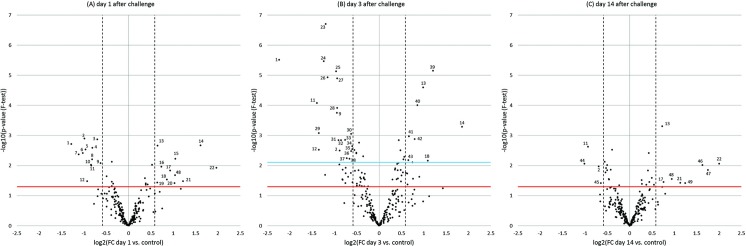
Volcano plots showing miRNA expression changes as obtained by RNAseq.A) day 1 after challenge, B) day 3 after challenge, C) day 14 after challenge. x-axes show the log2FC values of post-challenge time points vs. unchallenged controls. 50% up- or down-regulation is denoted by vertical dotted lines (log2FC > 0.585, log2FC < -0.585). y-axes show the -log10 transformed p-values obtained from F-tests. p = 0.05 is denoted by a horizontal red line. A horizontal blue line denotes the p-value limit for significant differential expression when controlling for FDR; as shown, only on day 3 after challenge are there any miRNAs that are significantly differentially expressed after this correction. miRNAs that pass the criteria for differential expression are marked with a number denoting their identity; miRNAs that appear in more than one volcano plot are marked with the same number in all plots. 1 ssc-miR-205; 2 ssc-miR-34c; 3 ssc-miR-671-5p; 4 ssc-miR-146a-5p; 5 ssc-miR-2366; 6 ssc-miR-365-5p; 7 ssc-miR-146b; 8 ssc-miR-708-5p; 9 ssc-miR-92b-5p; 10 ssc-miR-708-3p; 11 mmu-miR-34b-3p; 12 mmu-miR-34b-5p; 13 ssc-miR-339-3p; 14 ssc-miR-196b-5p; 15 ssc-miR-193a-3p; 16 ssc-miR-4334-3p; 17 ssc-miR-133b; 18 ssc-miR-217; 19 ssc-miR-331-3p; 20 ssc-miR-216; 21 ssc-miR-187; 22 ssc-miR-144; 23 ssc-miR-296-3p; 24 ssc-miR-92b-3p; 25 ssc-miR-1343; 26 hsa-miR-375; 27 ssc-miR-744; 28 ssc-miR-7134-5p; 29 ssc-miR-190b; 30 ssc-miR-2320-3p; 31 ssc-miR-671-3p; 32 ssc-miR-128; 33 ssc-miR-328; 34 ssc-miR-30c-1-3p; 35 ssc-miR-1296-5p; 36 ssc-miR-149; 37 ssc-miR-183; 38 ssc-miR-129b; 39 ssc-miR-221-5p; 40 ssc-miR-29b; 41 ssc-miR-142-5p; 42 ssc-miR-504; 43 ssc-miR-20a; 44 ssc-miR-1249; 45 ssc-miR-7139-3p; 46 ssc-miR-486; 47 ssc-miR-451; 48 ssc-miR-335; 49 ssc-miR-215.